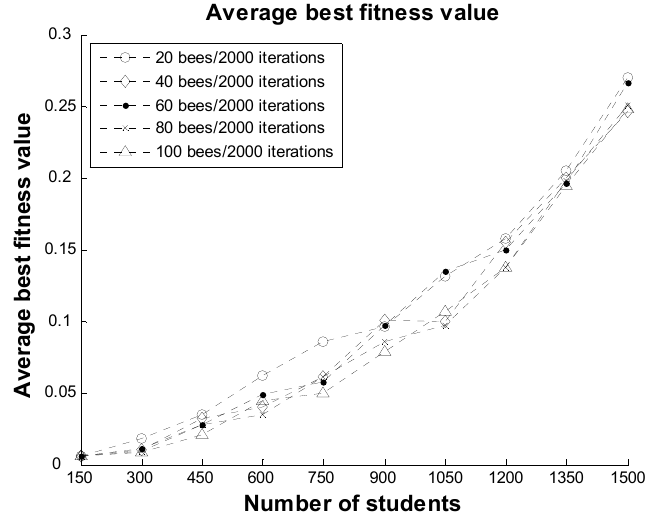
Figure 8. Average best fitness values with 2,000 iterations and different numbers of bees.